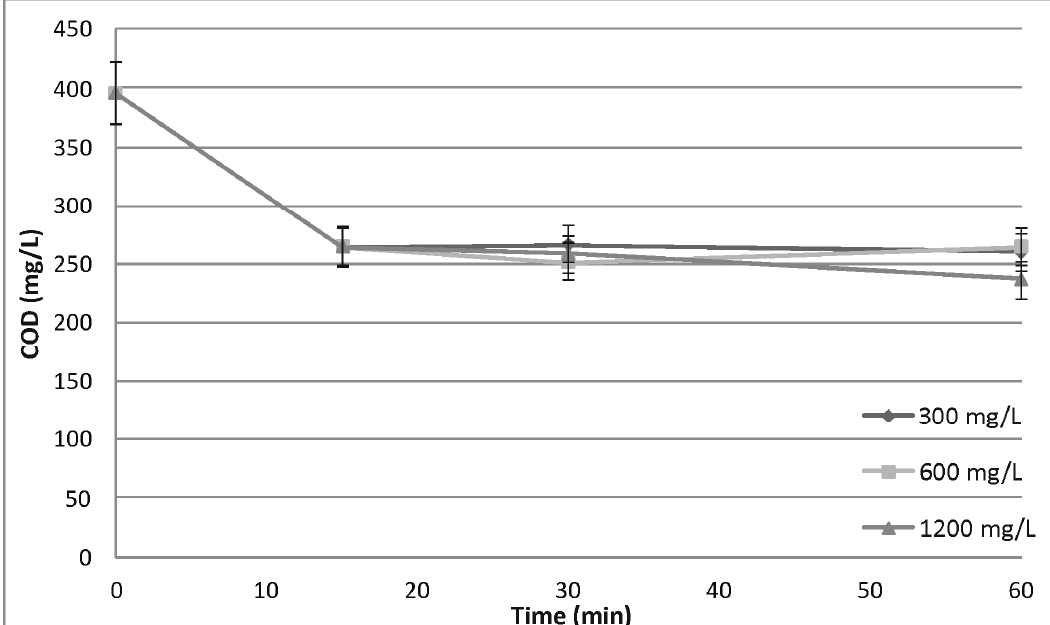
Figure 2. TOC (total organic carbon) removal in Fenton process: Fe 2+ dose 300 (mg/L), sedimented wastewater. Processes 2018 , 6 , x FOR PEER REVIEW